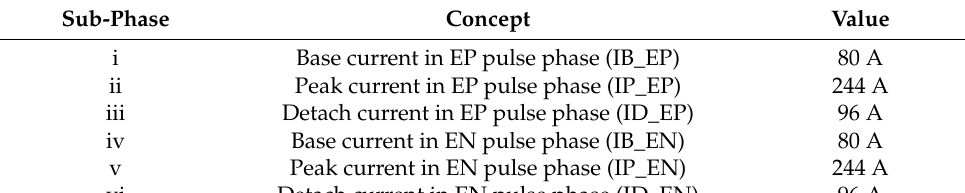
Figure 2. Schematic of current waveform used in the experiment. Table 3. Current parameters applied to yield the results shown in Figure 3.